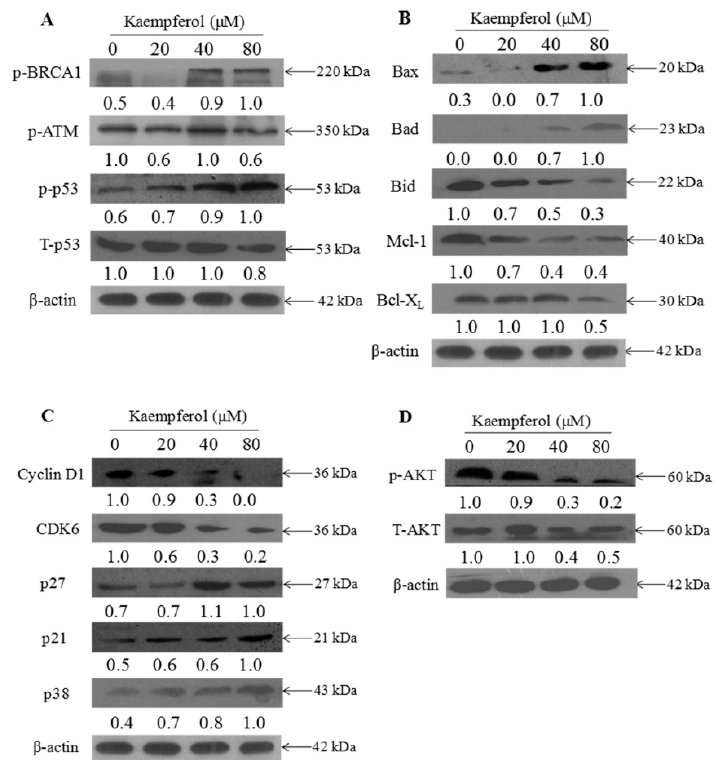
Figure 5. The expression levels of signal protein in EJ cells treated with kaempferol by western blotting. ( A ) p-BRCA1, p-ATM, p-p53, and T-p53. ( B ) Bax, Bad, Bid, Mcl-1, and Bcl-xL. ( C ) Cyclin D1, CDK6, p27, p21, and p38. ( D ) Phosphorylated AKT (p-AKT) and total AKT (t-AKT). β -actin was used as the loading control. The protein expression levels are percentages of the control. Relative intensity was shown above each immunoblotted protein and condition. Representative images of three independent experiments are presented.